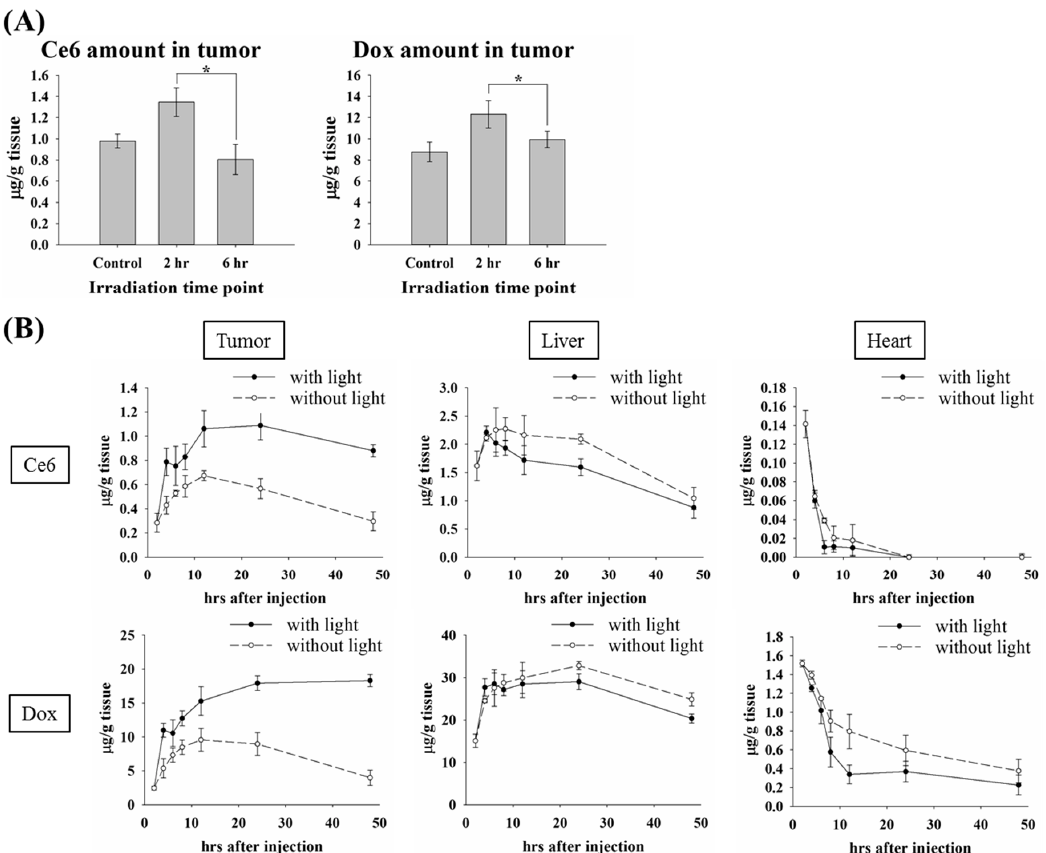
Figure 2. Drug concentrations of Ce6 and Dox in tumor and different tissues of C26 tumor-bearing mice with or without light irradiation. ( A ) Total Dox (right panel) and Ce6 (left panel) levels in whole tumor 12 h after PL-Dox-Ce6 (Ce6: 1.25 mg/kg and Dox: 5.87 mg/kg) administration. After drug administration, tumor tissues were irradiated without (control) or with light (100 J/cm 2 ) at 2 h and 6 h, respectively. The drug concentrations of tumor were further determined at 12 h post PL-Dox-Ce6 administration (* p < 0.05). ( B ) Time course of Ce6 and Dox concentrations in the tumor, liver and heart of C26 tumor-bearing mice without or with (100 J/cm 2 ) light irradiation at 2 h after PL-Dox-Ce6 injection (Ce6: 1.75 mg/kg; Dox: 8.31 mg/kg). Data are expressed as the mean ± S.D. for each group ( N = 3).